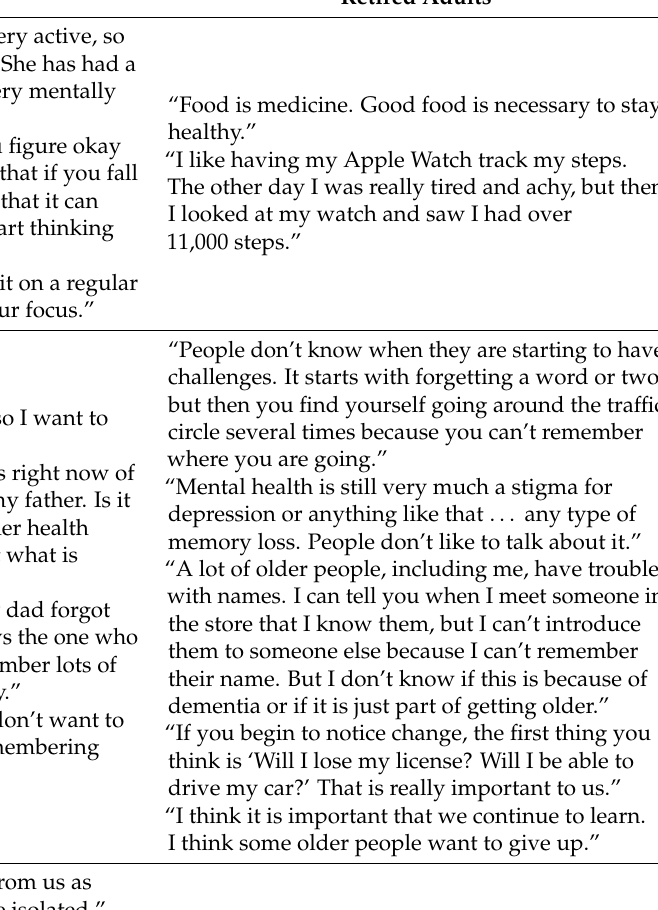
Table 2. Themes Identified Regarding Technology Use among Focus Groups of Older Adults. Themes Working Adults Retired Adults